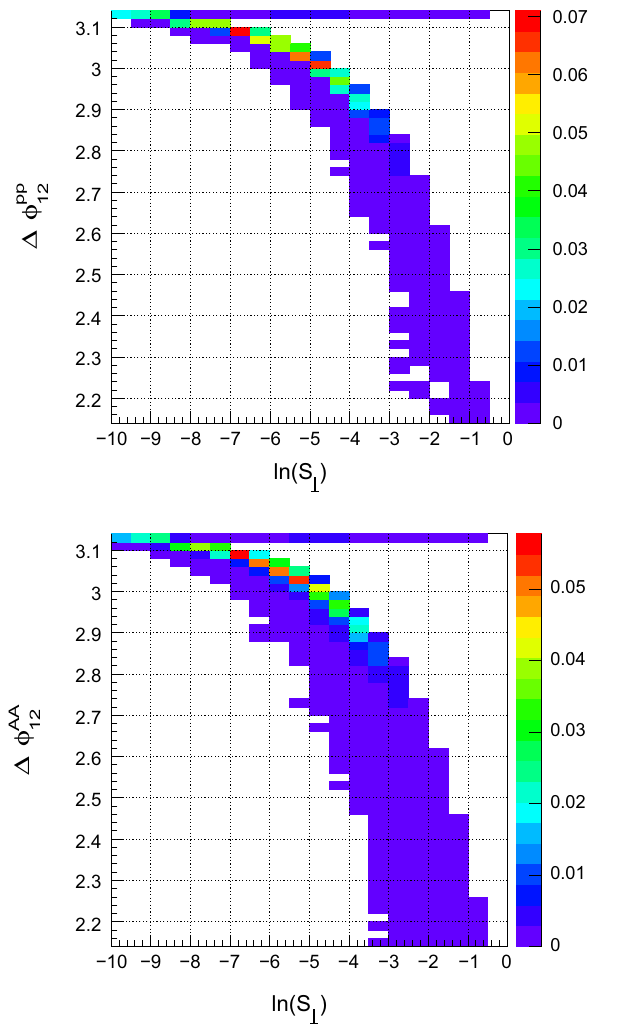
Fig. 8 Correlation between S ⊥ and (cid:2)φ 12 for n jet = 2 events in p+p (top) and Pb+Pb (bottom) collisions at